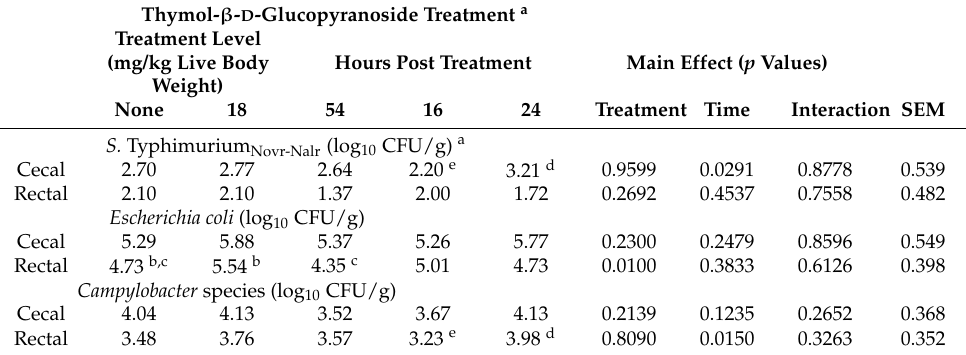
Table 2. Effect of oral thymol- β - D -glucopyranoside treatment on gut novobiocin- and nalidixic acid- resistant Salmonella Typhimurium ( S. TyphimuriumNovr-Nalr) and generic E. coli and Campylobacter species in weaned swine. Thymol- β - D -Glucopyranoside Treatment a Treatment Level (mg/kg Live Body